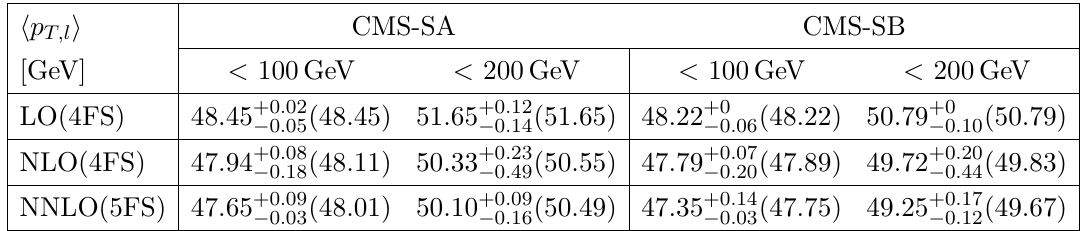
Table 4 . Average transverse momentum of the charged lepton within the two fiducial regions at various orders in QCD for LHC 13 TeV, comparing 5FS with 4FS. Scale variations are evaluated by taking the envelop of results with 9 scale choices. Numbers in parenthesis correspond to predictions without including QCD corrections in decay of top